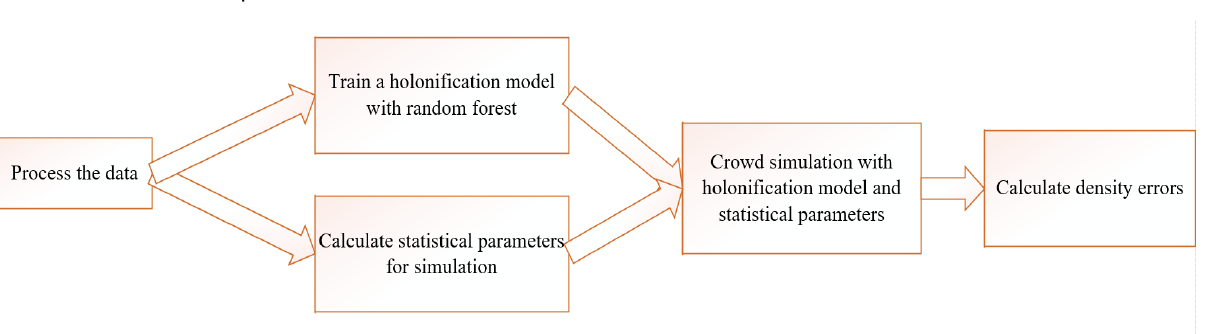
Figure 1. The main simulation